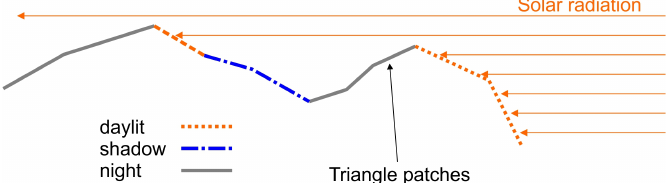
Figure 5. Direct radiation on the body surface. There are three types of triangles: day, night, and